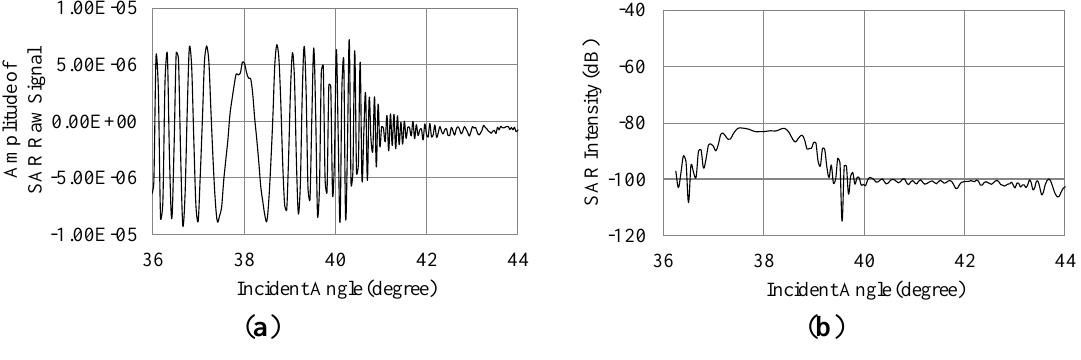
Figure 13. Influence Bragg resonant wave on microwave backscattering (Bragg resonant condition of 40 degrees). ( a ) Real part of SAR raw signal; ( b ) SAR intensity.